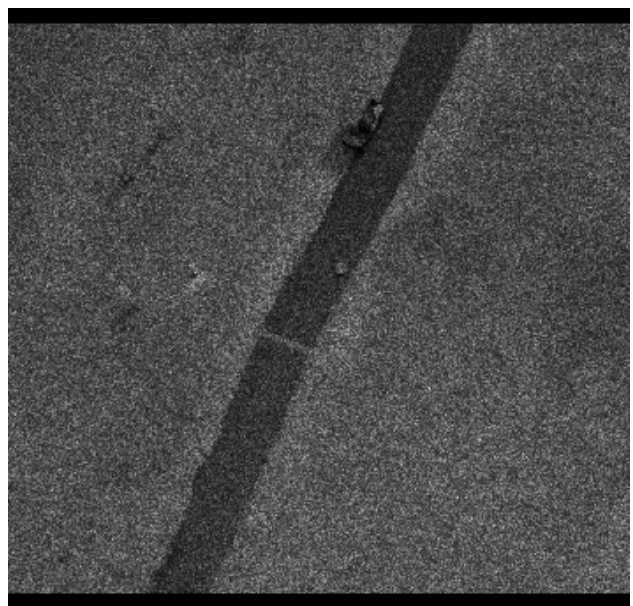
Figure 4. The reflectivity map with speckle ( µ = 0 and σ 2 = 100).